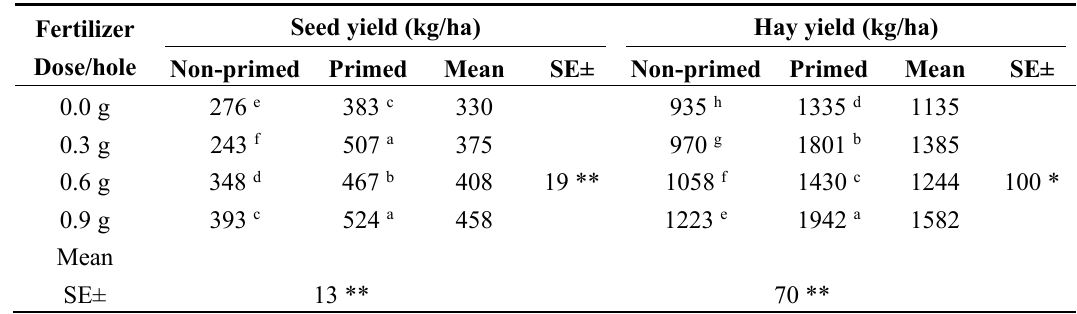
Table 7. Effect of seed priming and micro-dosing on sesame seed and hay yields (kg/ha), combined across two